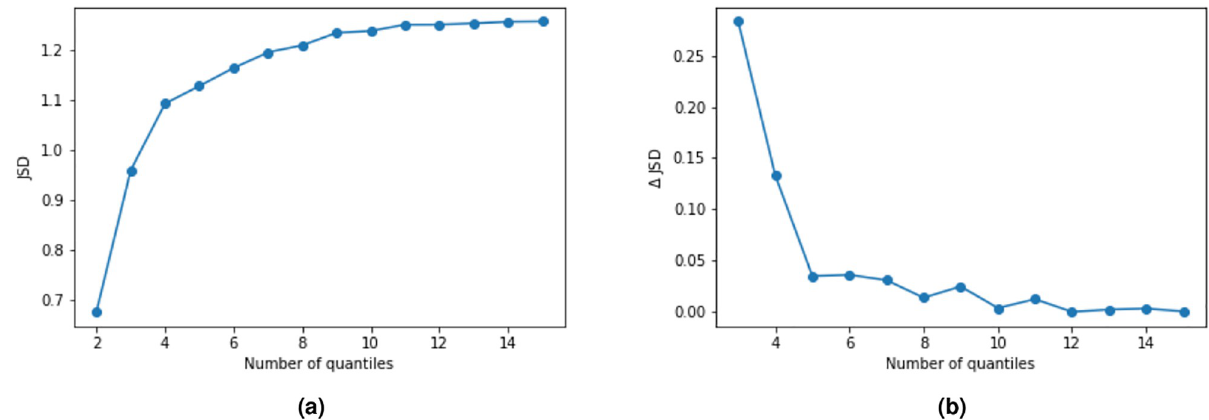
Fig 8. The Jensen-Shannon divergence (a) and its increments (b) when varying the number of quantiles in the ESCS-P space. After approximately six quantiles we gain little information by dividing further.